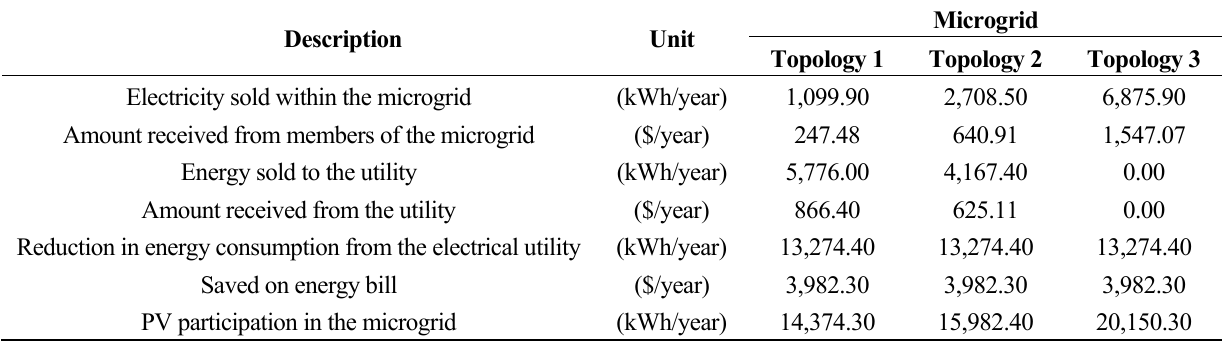
Table 7. Energy and economic aspects of microgrid Topologies 1, 2 and 3.